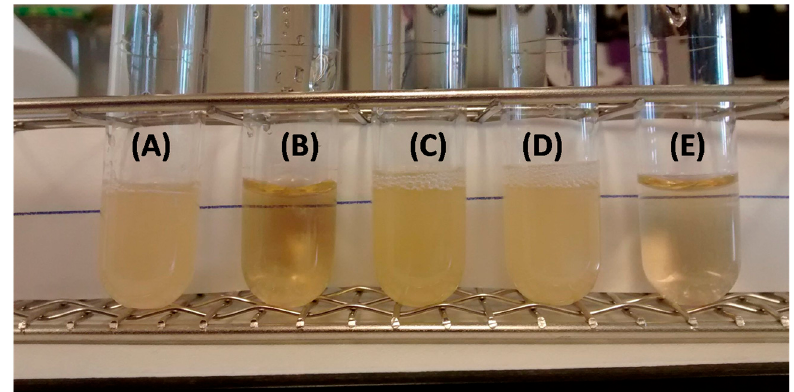
Figure 9. Antimicrobial activity of CS crosslinked scaffold ( A ); AgNPs-CS crosslinked scaffold ( B ); AgNO 3 crosslinked scaffold ( C ); AgNO 3 aqueous solution (Ag + : 6.25 ppm) ( D ); and AgNO 3 aqueous solution (Ag + : 12.5 ppm).